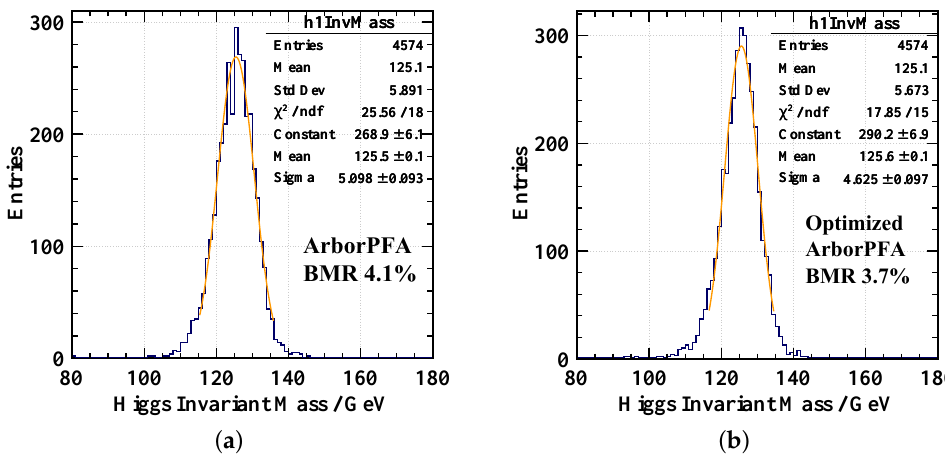
Figure 4. Higgs boson mass resolution with the ArborPFA algorithm. ( a ) BMR with the crystal ECAL using the default ArborPFA. ( b ) BMR with the crystal ECAL using the optimized ArborPFA.